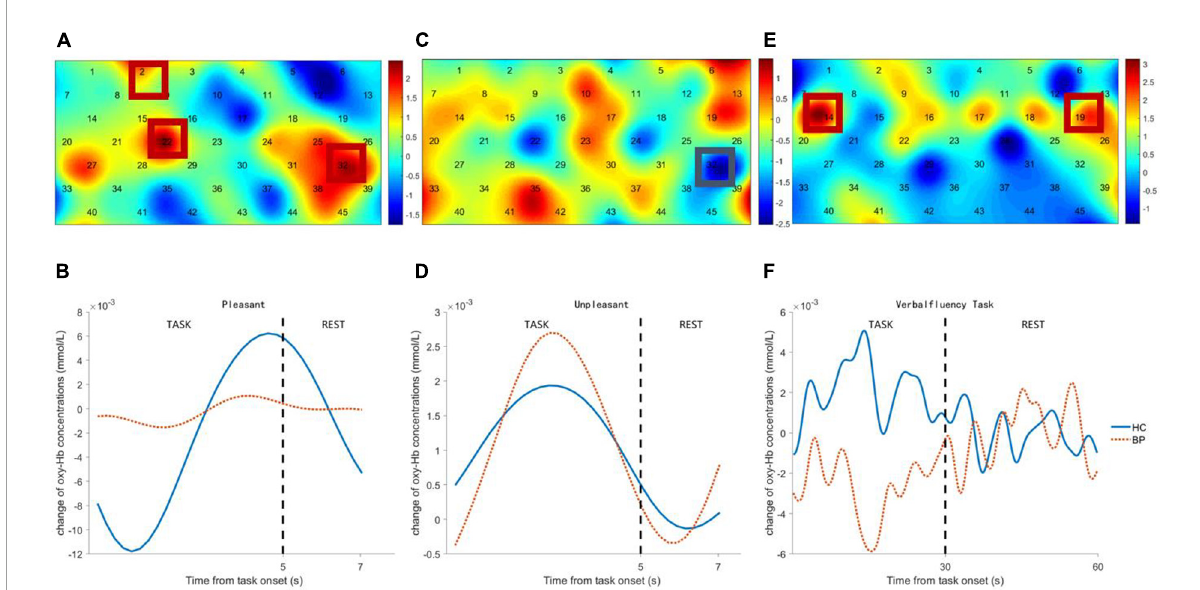
FIGURE3 Comparison between bipolar disorder (BD) patients and healthy controls (HCs) of frontal activation and time course of hemodynamic changes evoked by pleasant pictures (A,B) , unpleasant pictures (C,D) , and verbal fluency task (VFT) task (E,F) . The colormap represents the discrepancy ( t -value) of frontal cortex activation between BD patients and